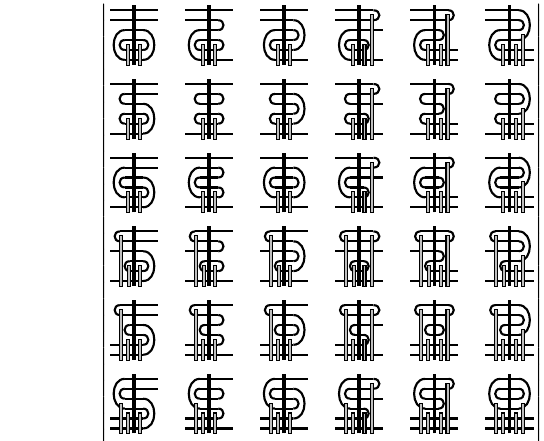
Figure 3: Graphical representation of the determinant of Gram matrix G 2 its usual form (left) and after applying the change of basis of lemma 3.8